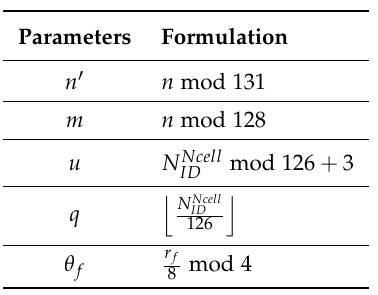
Table 2. Derivation of the parameters in